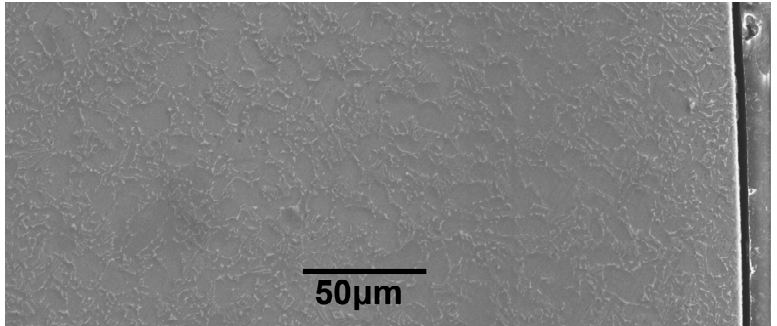
Figure 4. The cross-sectional microstructure of the USRP sample.